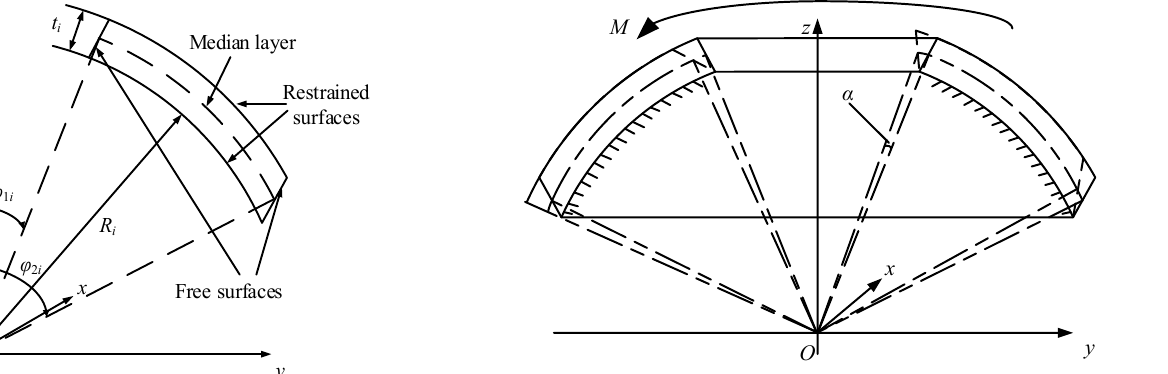
Figure 3. A single rubber layer of the flexible joint.